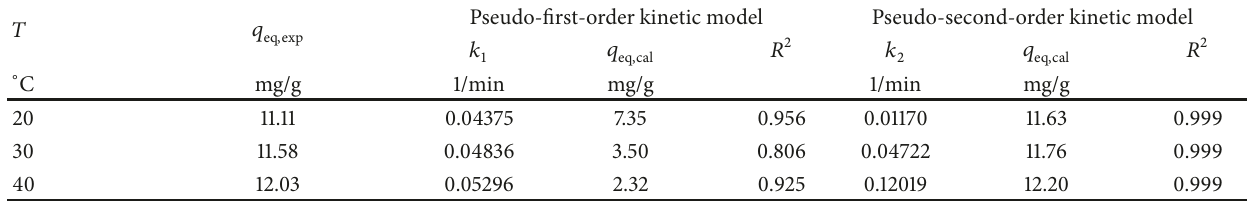
Table 4: The change with temperature on pseudo-first- and pseudo-second-order reaction rate constants. 𝑇